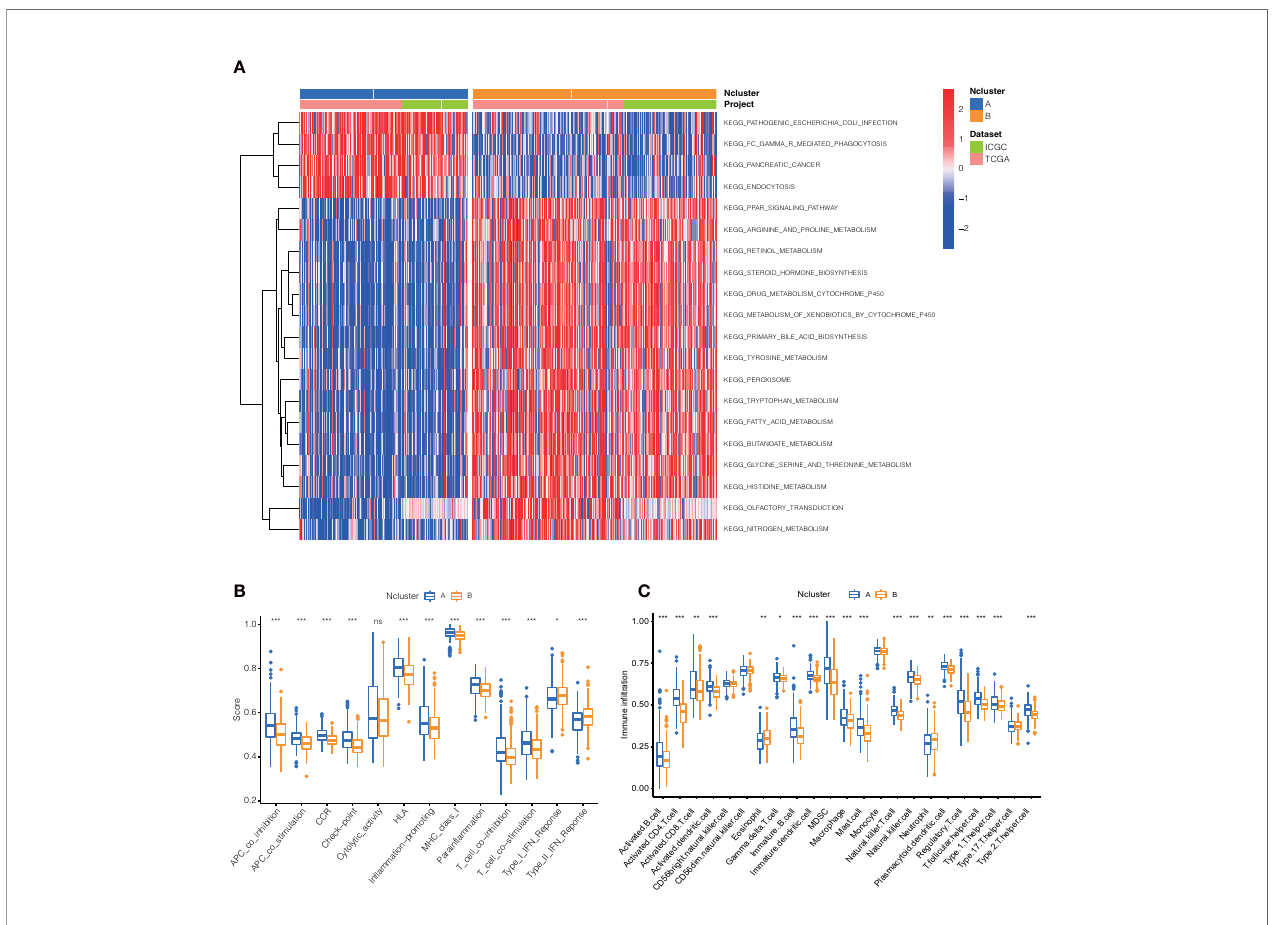
FIGURE 3 | Dramatic difference of biological features between Ncluster A and B. (A) Heatmap showed various KEGG pathways were enriched in Ncluster A and B. (B) Immune function and in fi ltrating immune cells (C) altered in two Nclusters shown by violin diagram. The heatmap was used to visualize these biological processes, and red represented activated pathways and blue represented inhibited pathways. Ncluster, necroptosis